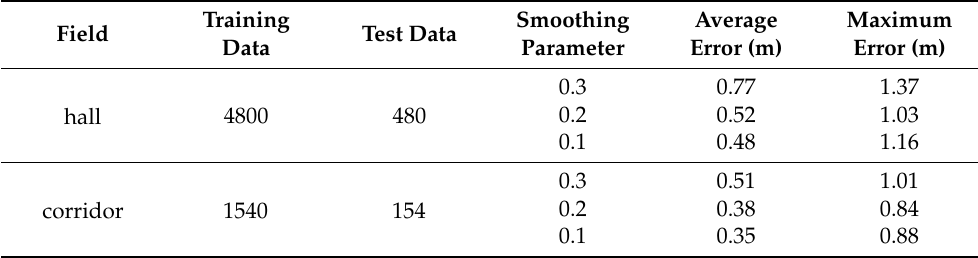
Table 2. Performance comparison of different smoothing parameters for